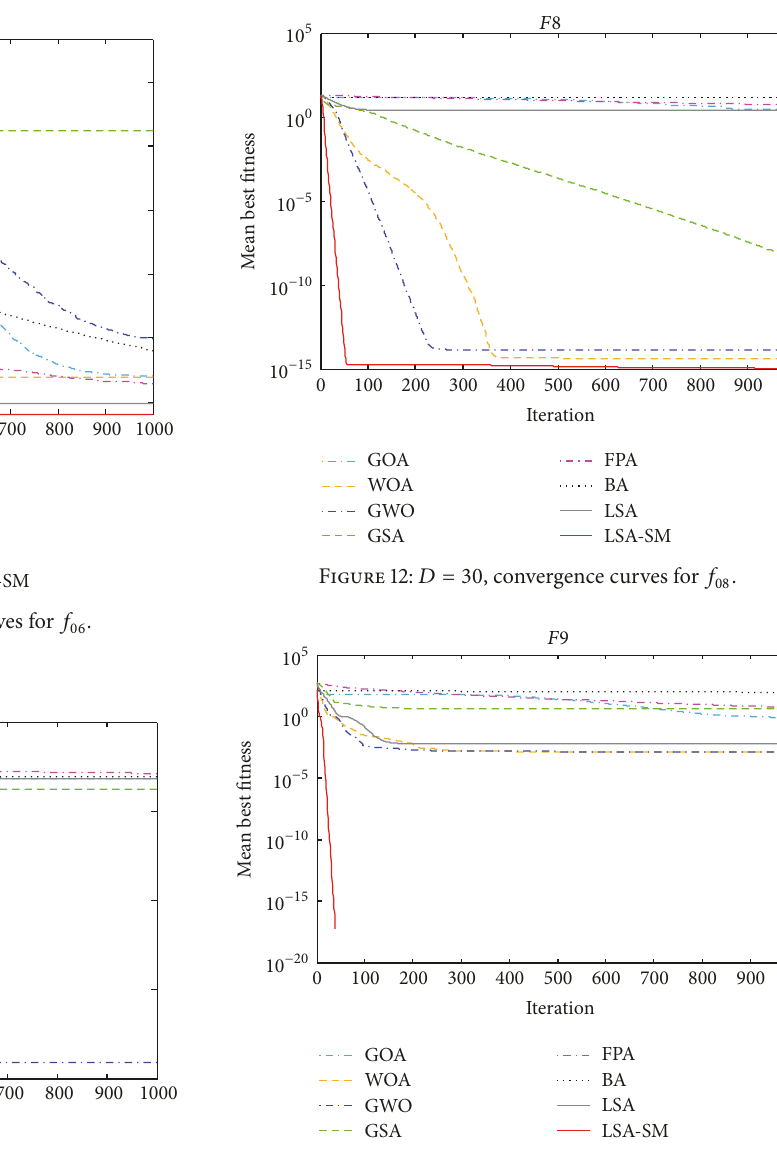
Figure 13: 𝐷 = 30 , convergence curves for 𝑓 09